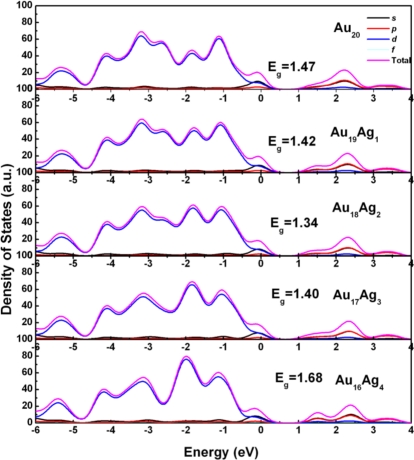
The partial DOS of (a) Au20−nAgn clusters.